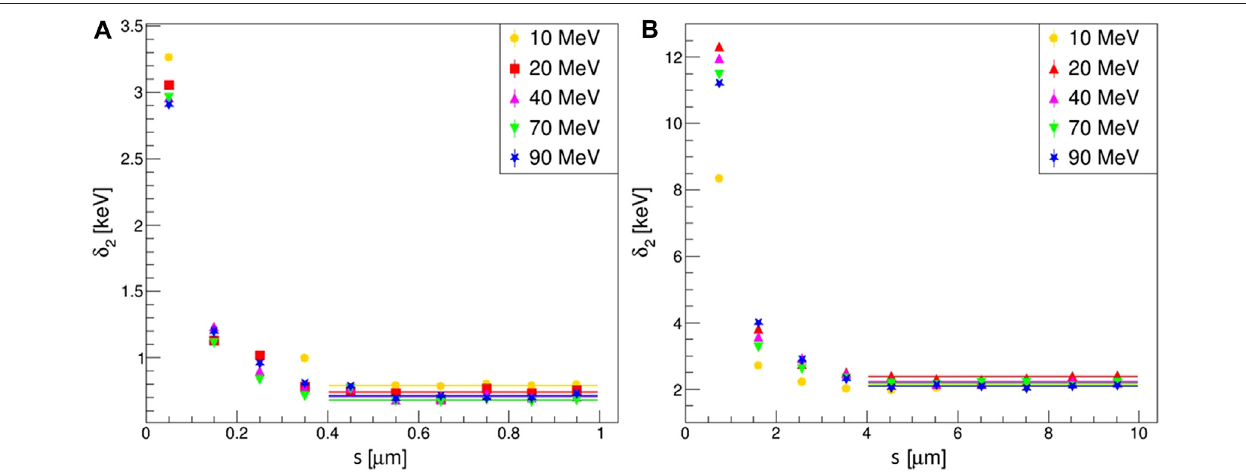
FIGURE6| Variation of δ 2 asafunctionoftheprotontrajectory length s withinthesite,obtainedwithweightedrandomsampling forthedifferentenergies. (A) sites of 1 μ m diameter, (B) sites of 10 μ m diameter. For the lower δ 2 values, the main contribution to δ 2 is given by the δ -ray in fl ux, whose in fl uence decreases quickly as s increases. For s > d /2, the value of δ 2 can be considered as constant. Since (cid:1) l F > d /2, the fi nal values of δ 2 were extracted by averaging the points (weighted by their uncertainties) in the range s > d /2 (solid lines).